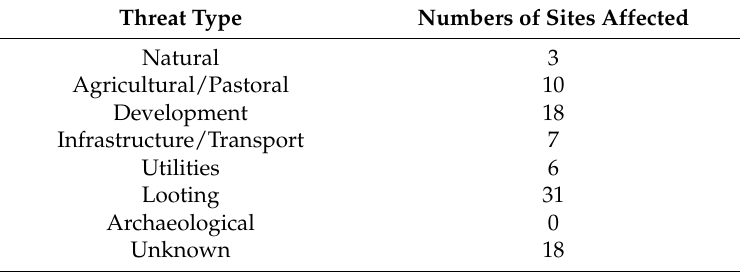
Table 8. Potential threats which may affect Cyrene in the